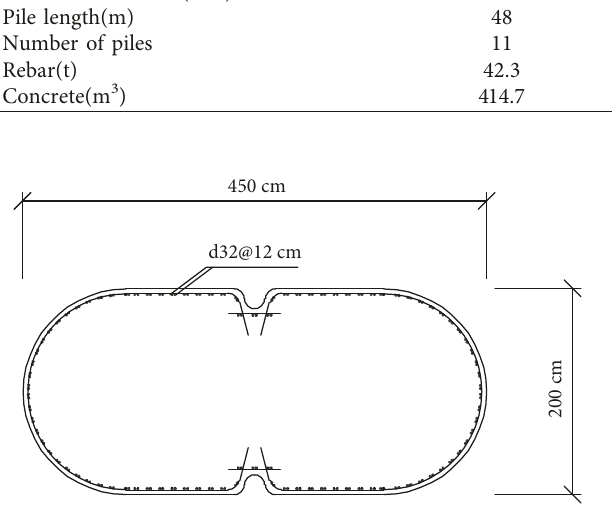
Figure 7: Pier reinforcement detail (cross-section). Figure 8. The beam and pier sizes and the materials adopted are as same as the scheme (i).